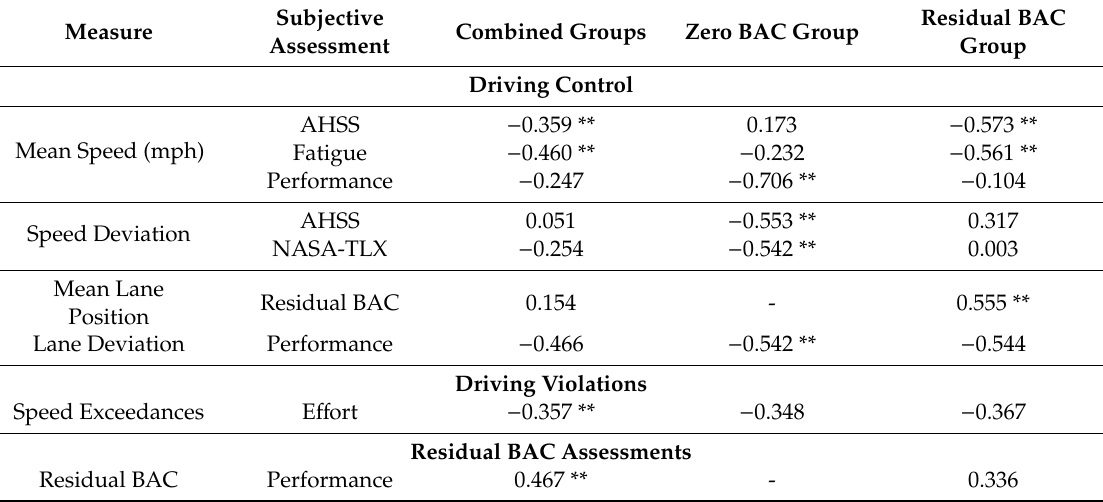
Table 2. Associations between Driving Performance and Subjective Assessments (Pearson’s r